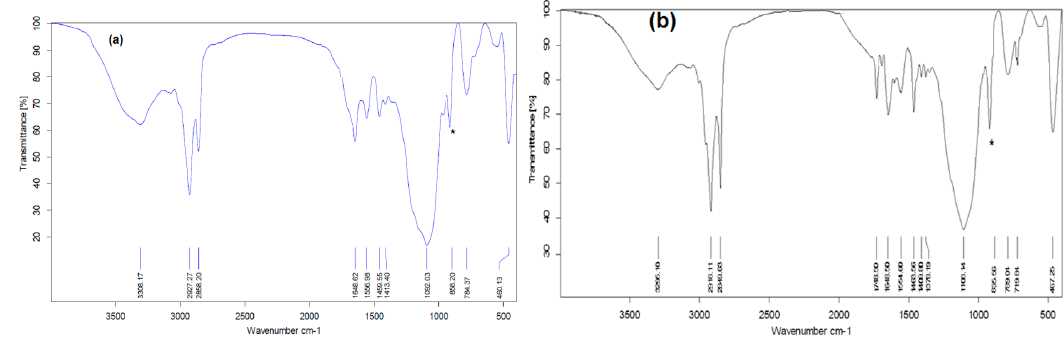
Figure 3. FTIR spectrum of ( a ) HSNP-1 and ( b ) HSNP-2.